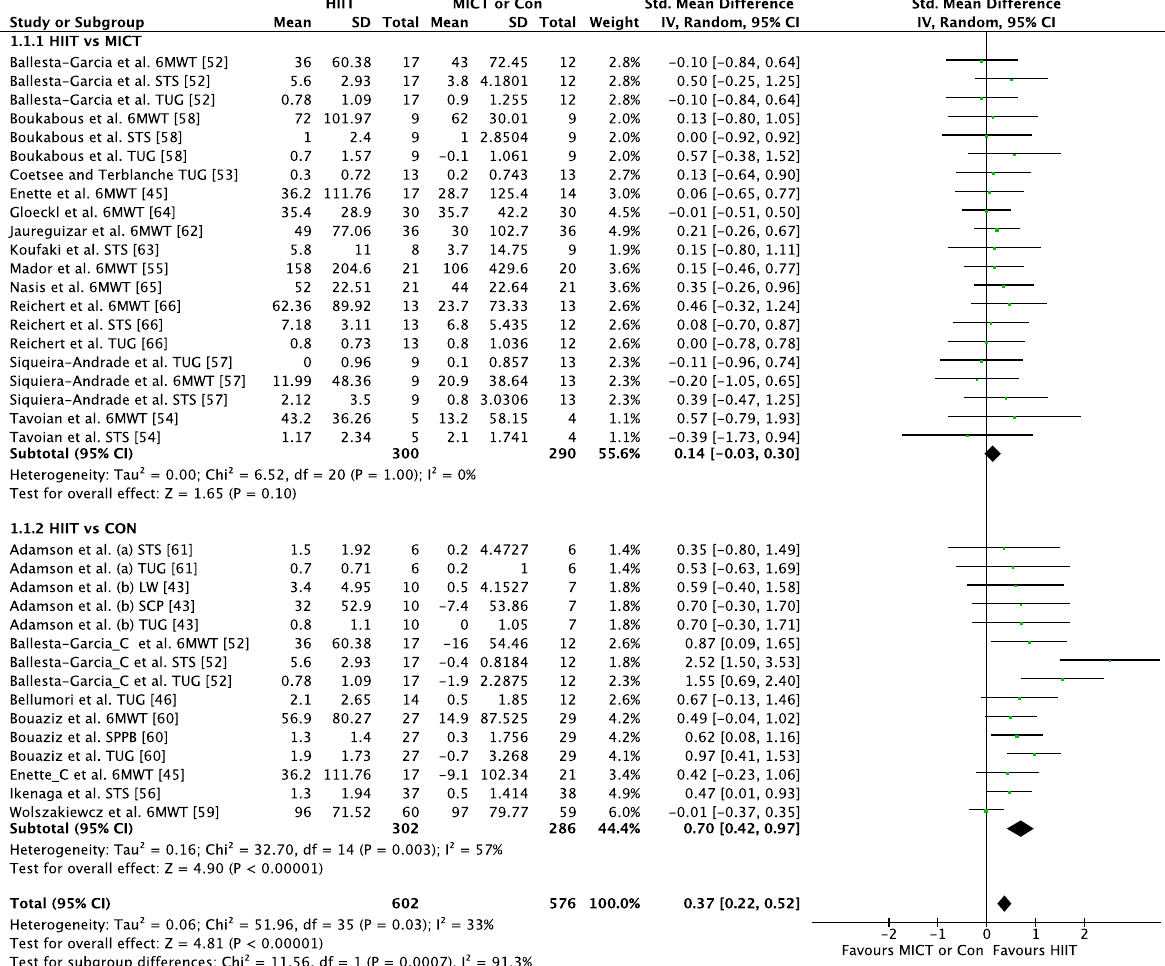
Fig. 3 Meta-analysis subgroups HIIT versus MICT, HIIT versus Control with all functional movement outcome measures for each